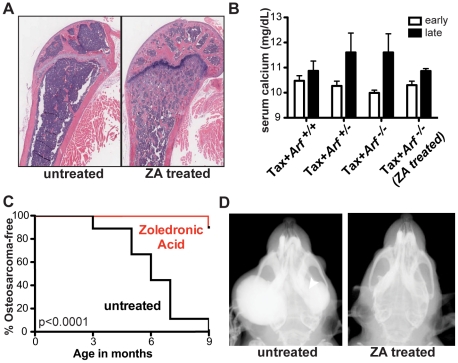
Zoledronic acid administration prevented osteosarcoma development in Tax+Arf
-/- mice.Tax+Arf-/- animals were treated with 0.75 ug of zoledronic acid (ZA) once weekly from 1 month until 9 months of age. Appearance of OS was monitored monthly by manual examination and radiography. a) ZA treatment reduced OC bone resorption as shown by high trabecular bone volume. b) ZA treatment prevented hypercalcemia in Tax+Arf-/- mice. c) Incidence of OS. p<0.0001 by Log-rank test. d) Representative radiographs of 9-month-old Tax+Arf-/- mice untreated (left) or treated with ZA (right).